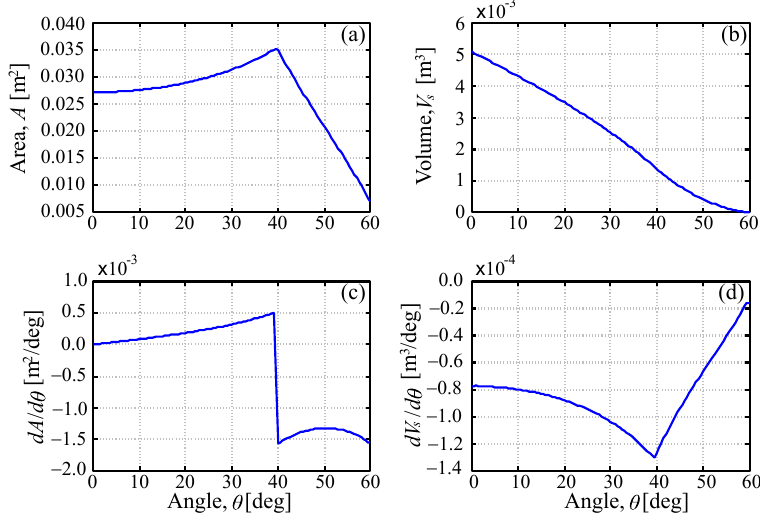
Figure 9. Model parameters of ladle. ( a ) Horizontal area on pouring mouth; ( b ) Volume under pouring mouth; ( c ) Derivative of horizontal area A with respect to angle θ ; ( d ) Derivative of volume V s with respect to angle θ